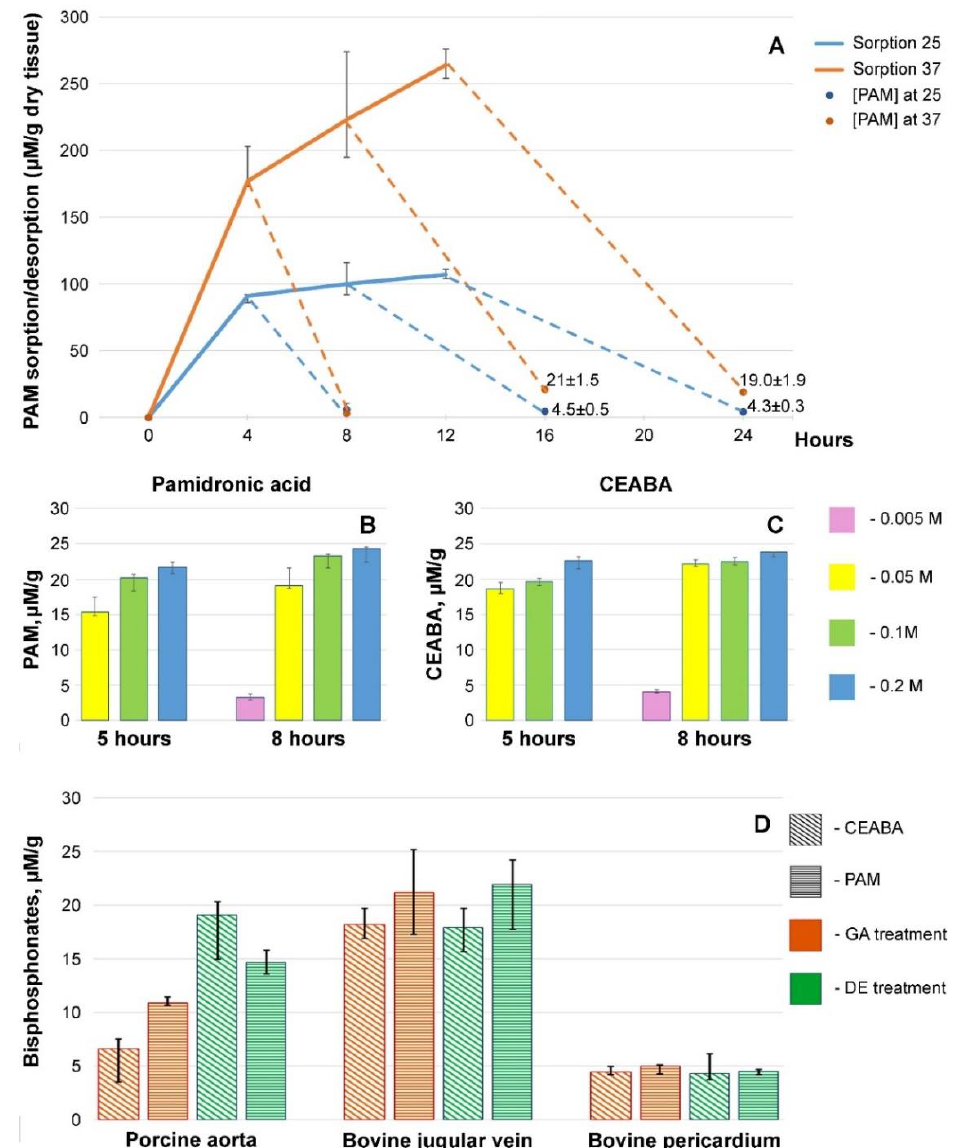
Figure 2. Dynamics of PAM sorption by DE-Ve and desorption of unbound drug. ( A ) Sorption at 25 °C (blue line) and desorption at 25 °C (blue dotted line); sorption at 37 °C (orange line) and desorption at 37 °C (orange dotted line). Amounts of bound PAM ( B ) and CEABA ( C ) (µM/g dry tissue) in bovine jugular vein wall after 5 h and 8 h treatment with the BPs at different concentrations at 37 °C. ( D ) BP concentrations in the biomaterials studied.